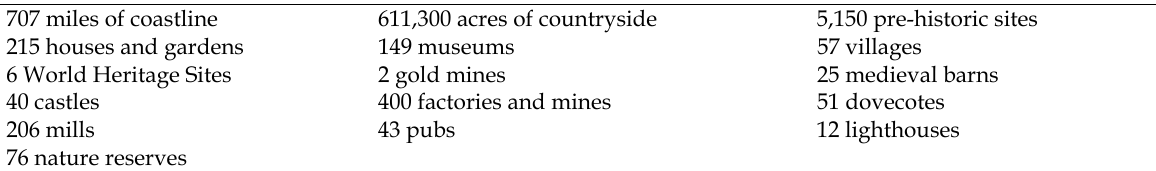
Table 2. National Trust